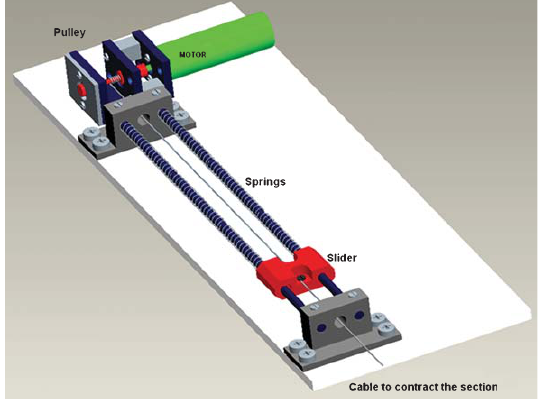
Fig. 4. Slider to actuate a miniature stainless wire rope.